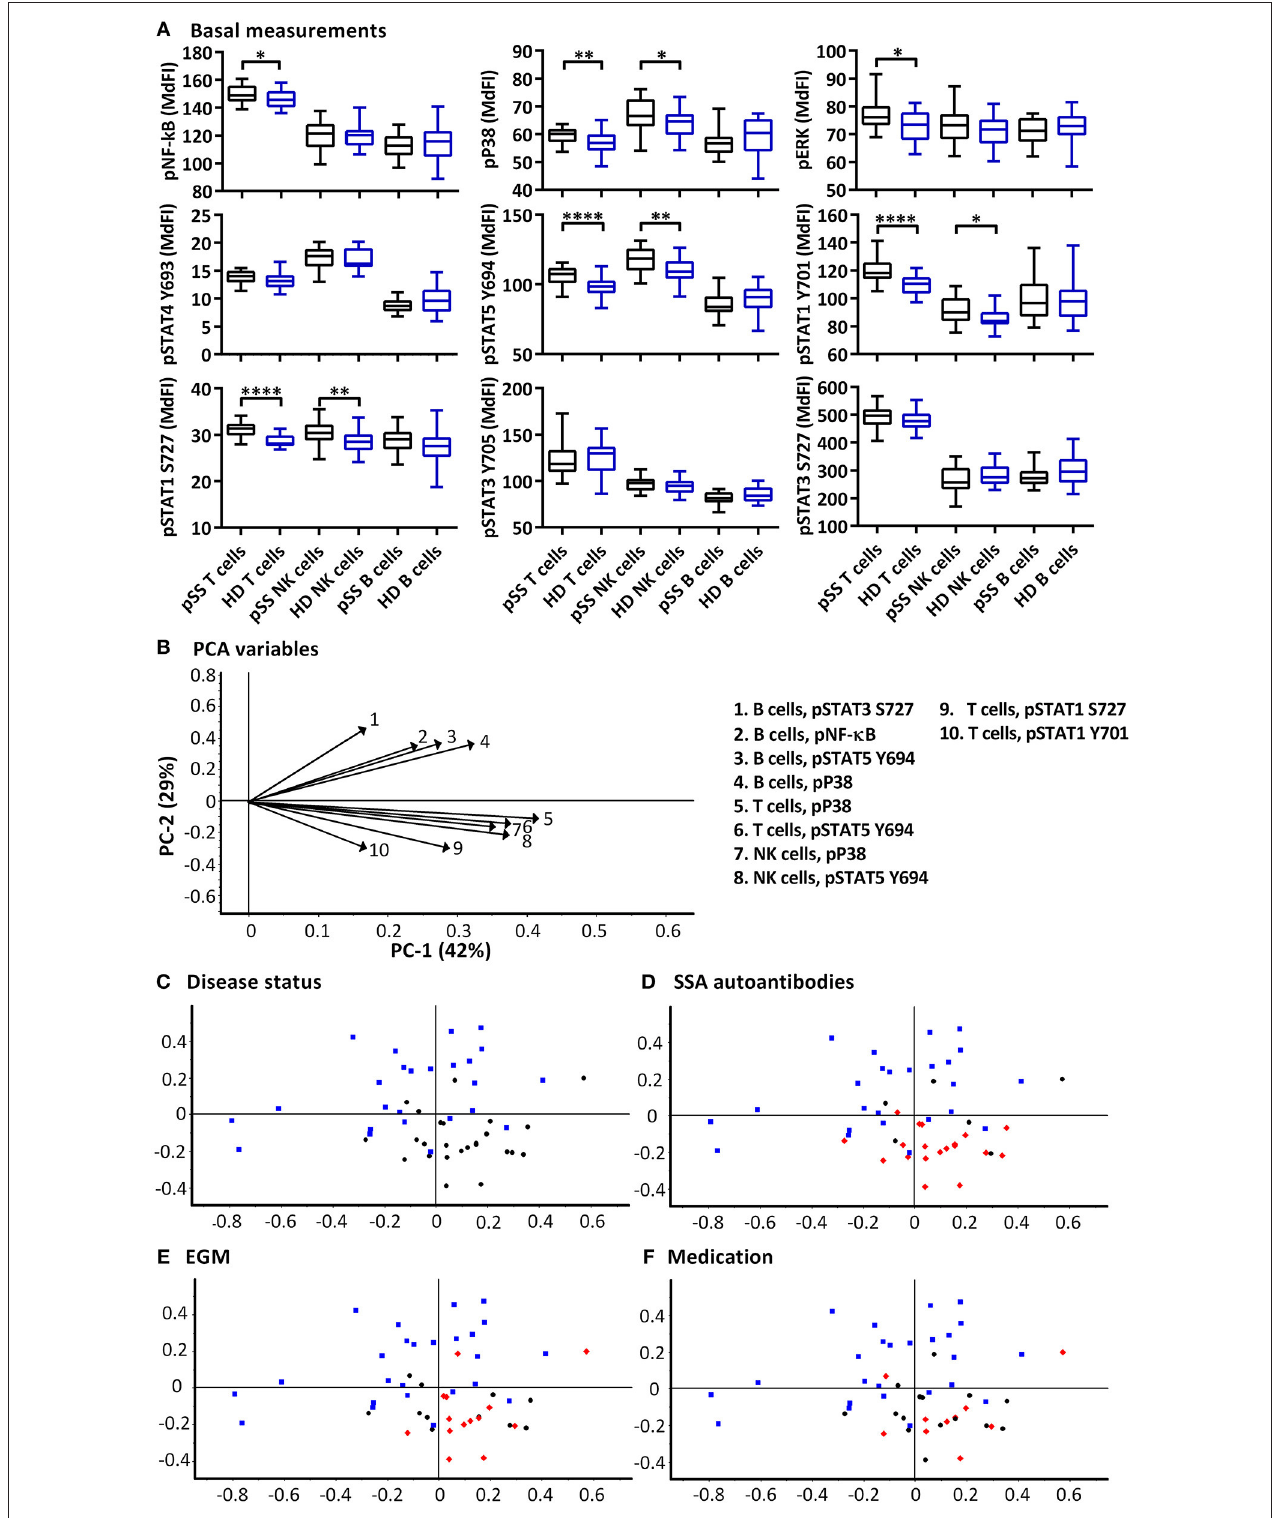
FIGURE 1 | Basal phosphorylation profiles in B cells, T cells and NK cells of pSS patients differ compared to healthy controls. Basal phosphorylation levels of NF- κ B, P38, ERK1/2, STAT4 Y693, STAT5 Y694, STAT1 Y701, STAT1 S727, STAT3 Y705, and STAT3 S727 were analyzed by flow cytometry in T cells, B cells and NK cells are given in (A) . Comparisons of phosphorylation levels (MdFI) between healthy donor (blue) and pSS patient (black). Comparisons between pairs were done using an